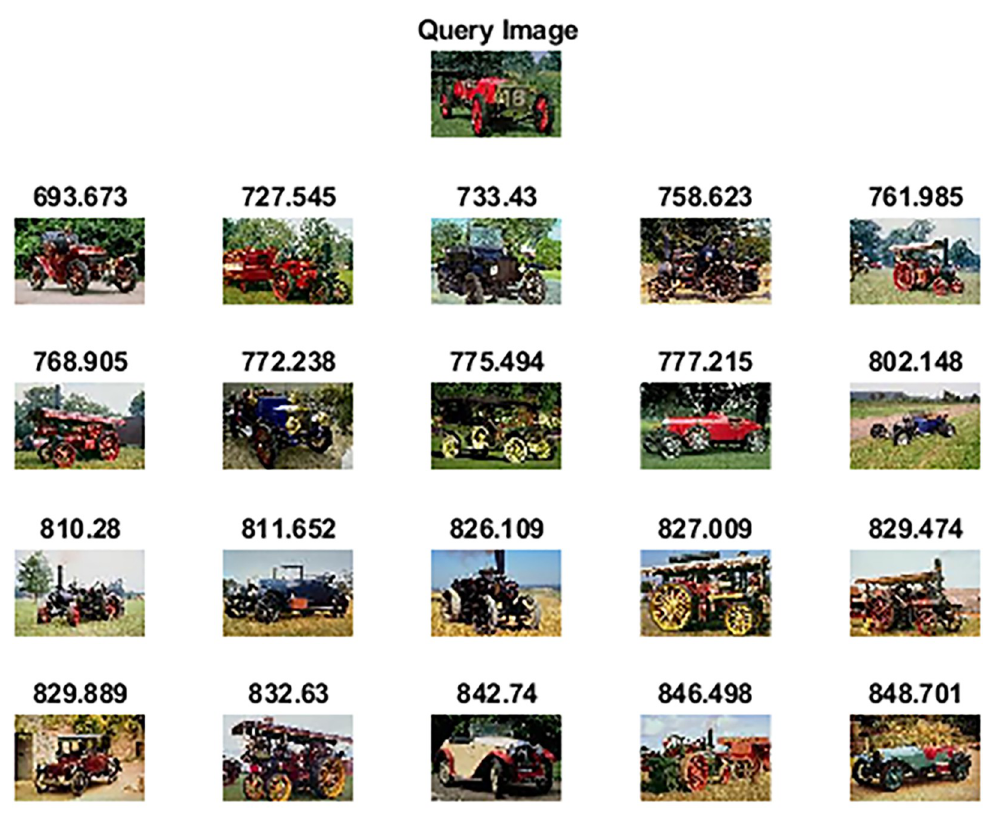
Fig 13. Top-20 retrieved images against a query image (class: Car) (reprinted from [3] under a CC BY license, with permission from J. Z. WANG, original copyright [2003]).